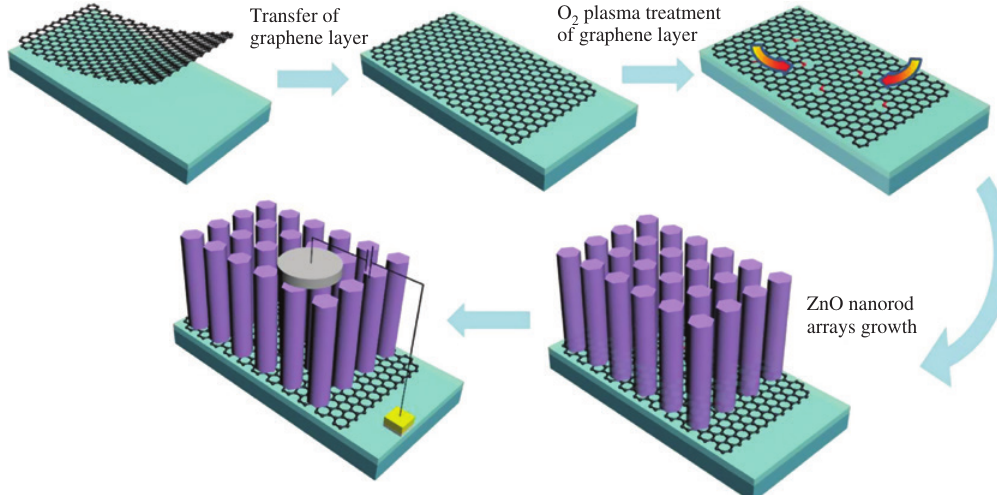
Figure 1: Schematic of graphene transfer and device preparation